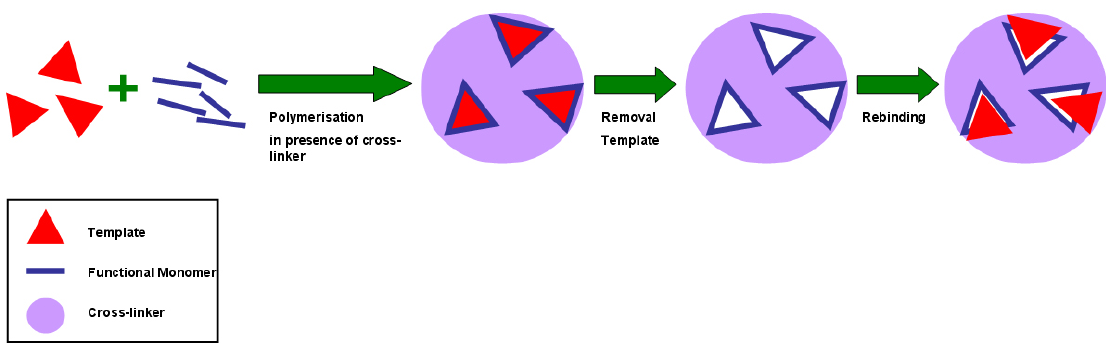
Figure 2. Schematic representation of molecular imprinting